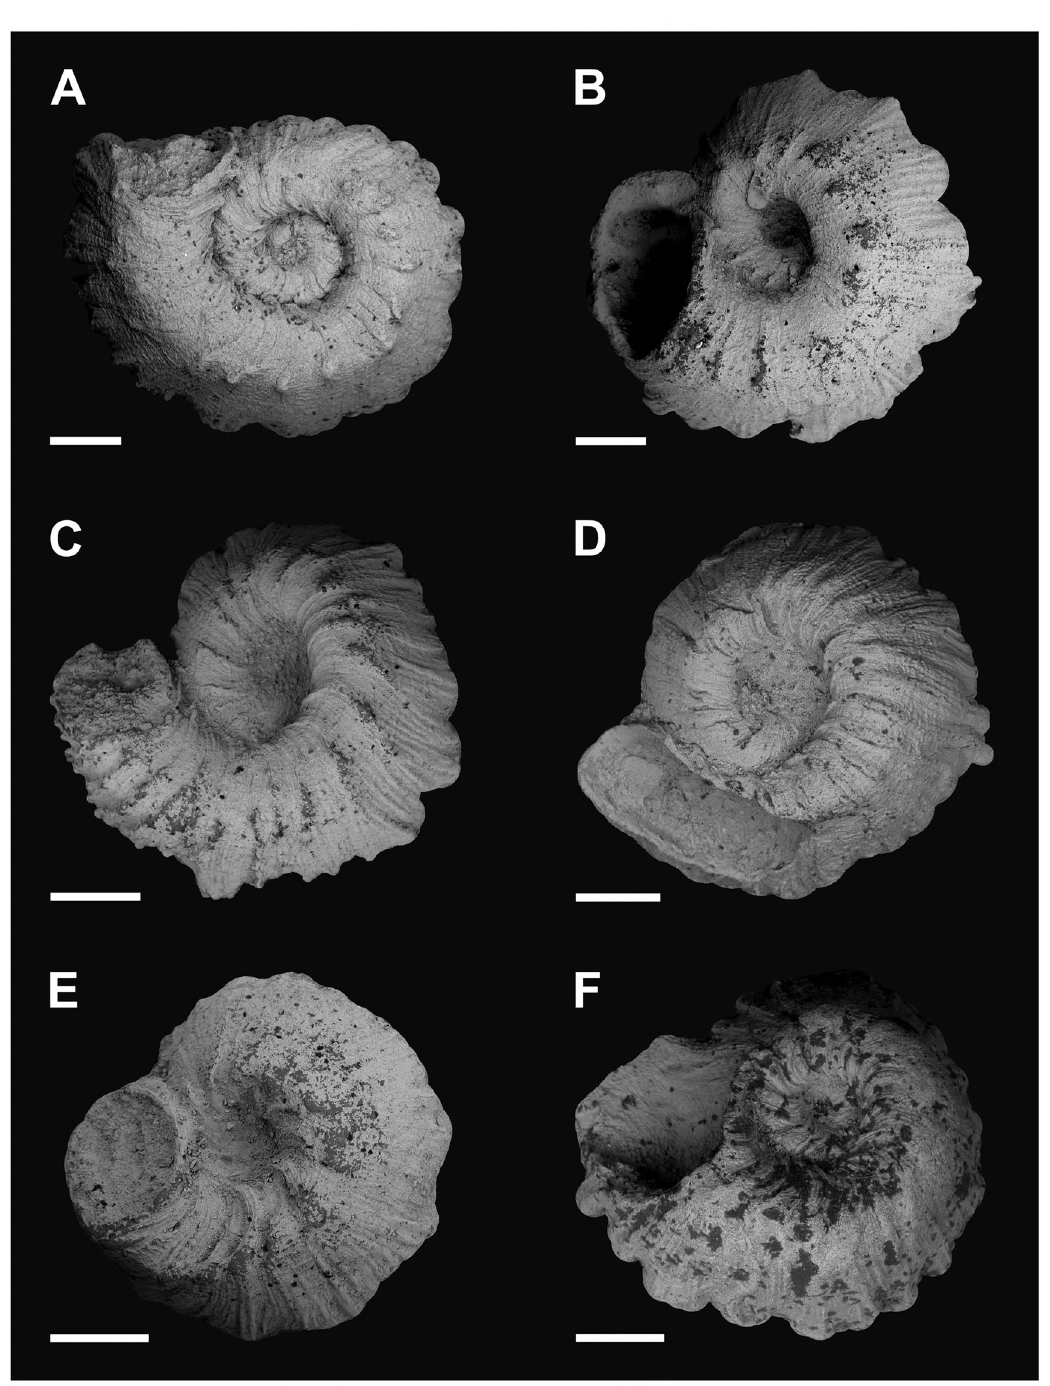
Fig. 3. Palaeoconchus wilsoni sp. nov. from Saaremaa Island, Estonia ( A – E ) and Gotland, Sweden ( F ). A, holotype, GIT